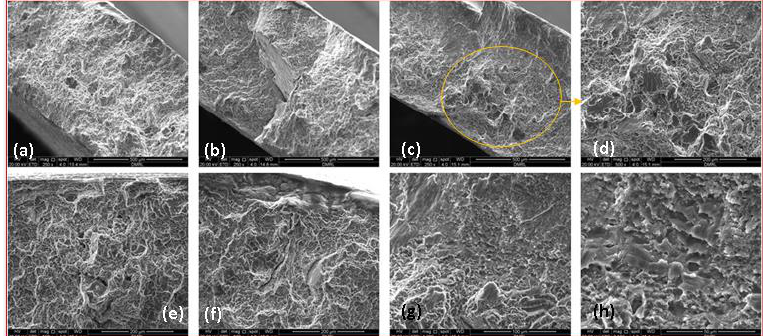
Figure 9: Fracture surface of mating part of connector 1 in different views, as seen under SEM